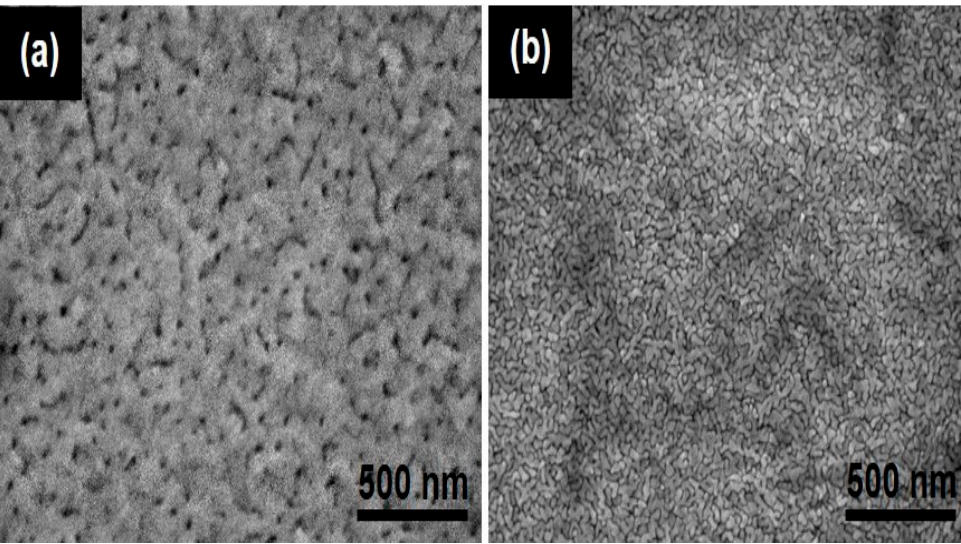
Figure 1. FE-SEM surface micrographs of the FePt films ( a ) without and ( b ) with a total of 2 nm MgO additive nanolayers were obtained by secondary electron image (SEI) mode, respectively.